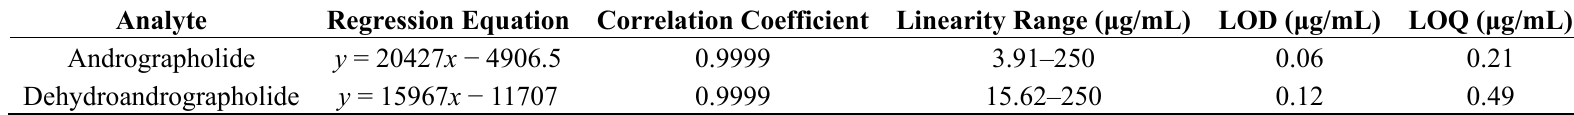
Table 1. The results of LODs, LOQs, regression equations, correlation coefficients and linearity ranges of andrographolide and dehydroandrographolide.